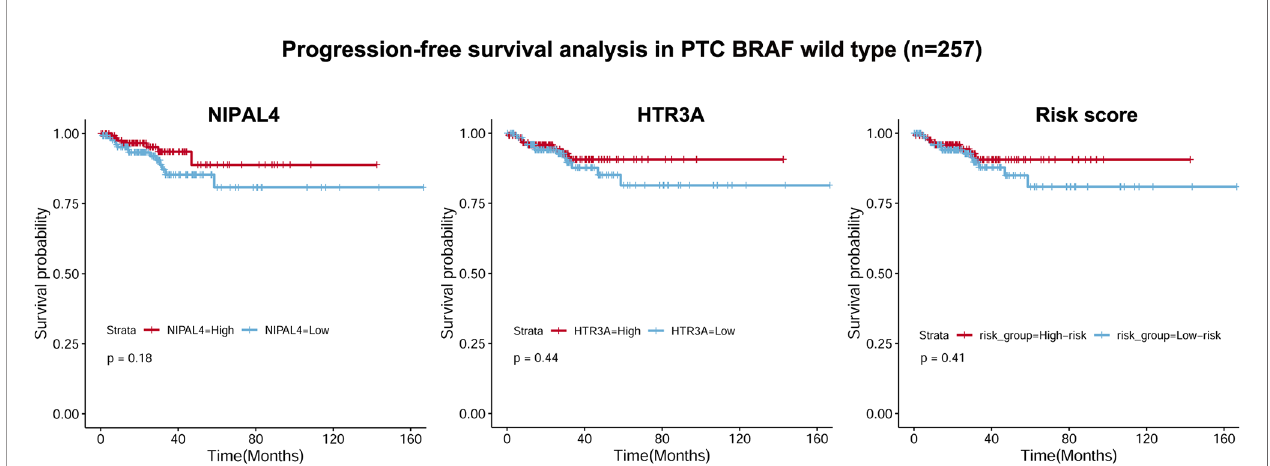
FIGURE 8 | Correlations of NIPAL4 expression, HTR3A expression and risk score with PFS in BRAF wild-type PTC (n = 257). The Kaplan – Meier survival curves showed that PFS did not differ signi fi cantly (all p > 0.05) between the low/high NIPAL4 groups, the high/low HTR3A groups and the high/low risk score groups in the BRAF wild-type PTC